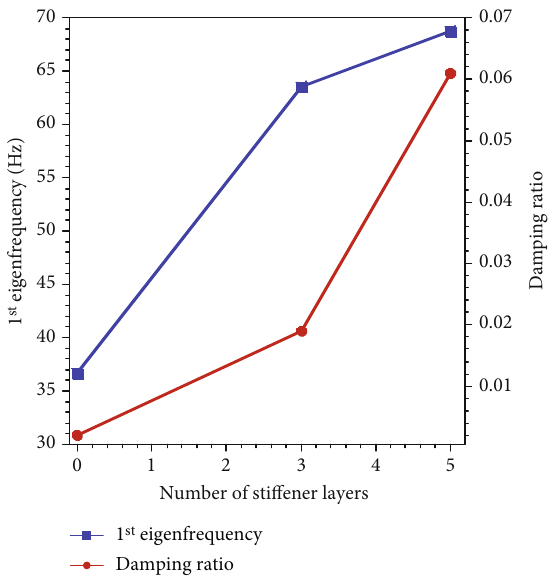
Figure 5: 1 st eigenfrequency and damping ratio of the solar panel according to the number of sti ff ener layers.